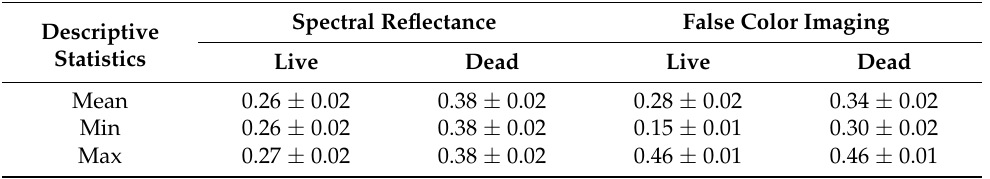
Table 6. Measured slope on reflectance of living and dead pupae specimens using 630 nm and 940 nm